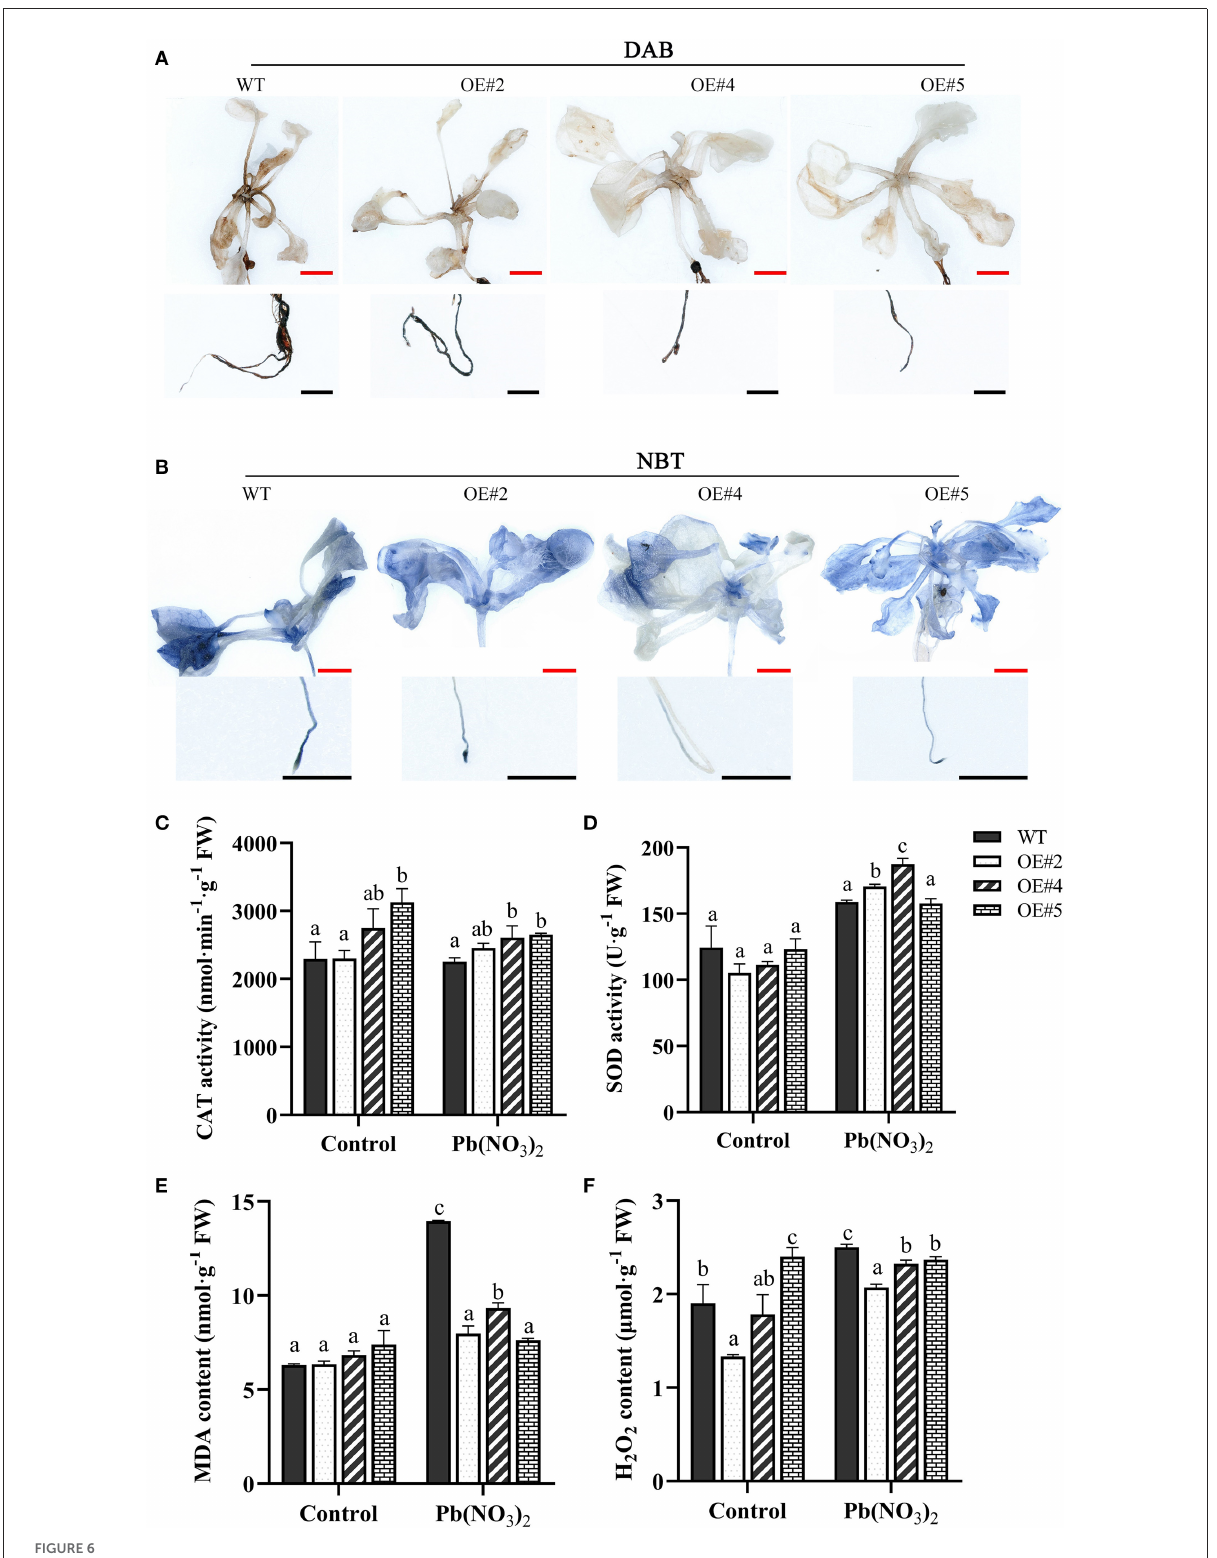
FIGURE6 Analysis of ROS accumulation and the activities of the antioxidant enzymes. Accumulation of H 2 O 2 and O 2 − in transgenic MePMEI1 and WT Arabidopsis seedlings by (A) DAB and (B) NBT staining following treatment with 750 µ M Pb(NO 3 ) 2 for 14 days. The images were captured using a stereomicroscope. Black scale bars = 500 µ m, red scale bars = 1mm. Activities of (C) CAT and (D) SOD, and the contents of (E) MDA and (F)